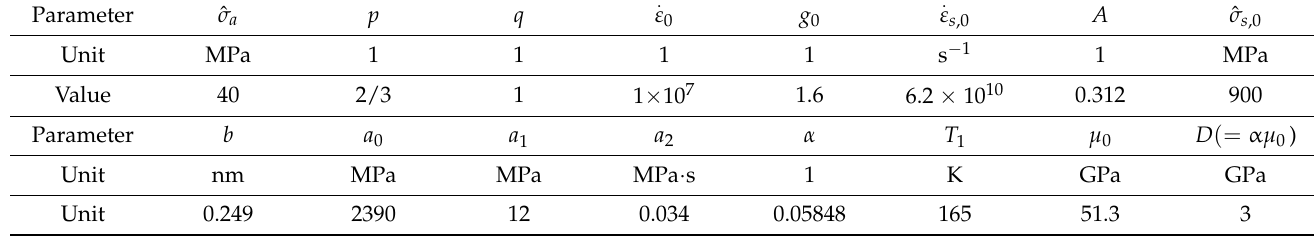
Table 13. Parameters of the FK model for copper ( T m = 1356 K)) [26–31].